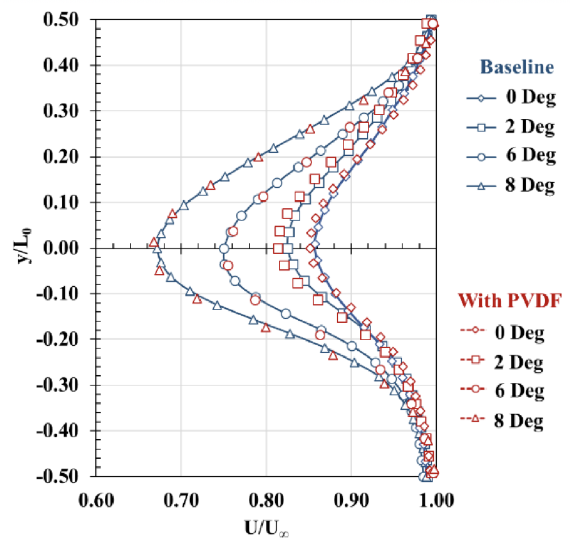
Figure 19. Momentum deficit profiles in the wake of NACA 0012 airfoil with and without PVDF at different angles of